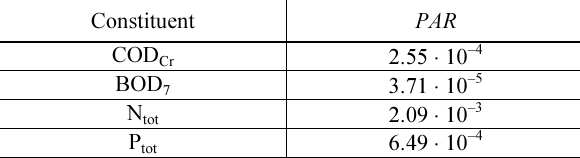
* for the Merkys River Basin